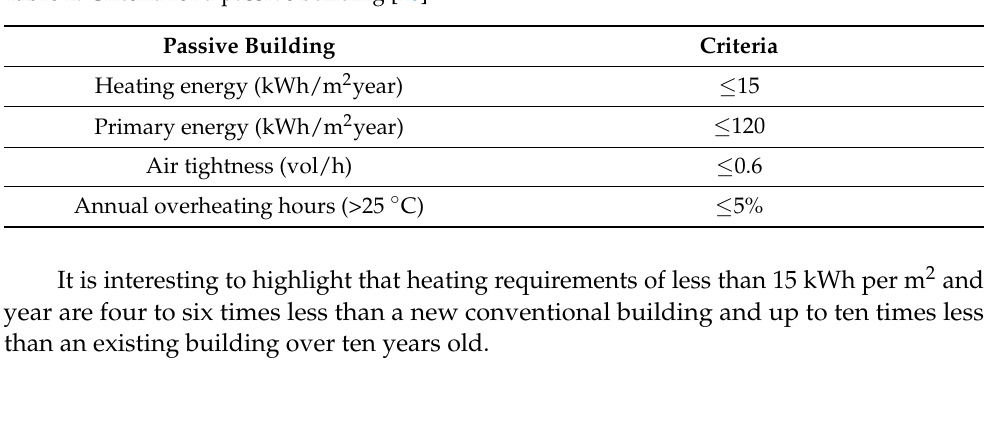
Table 2. Criteria for a passive building